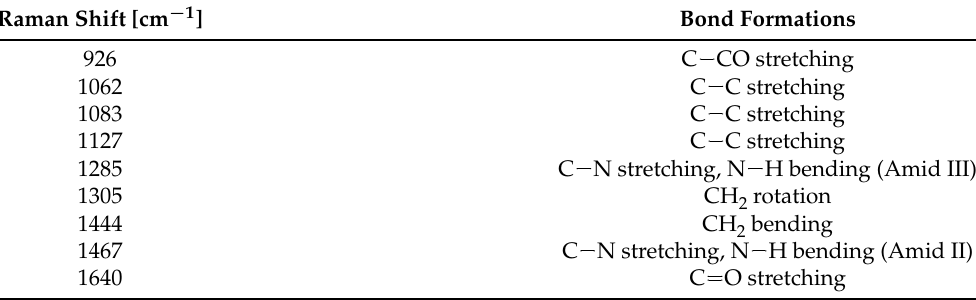
Table 4. Identified and presumed chemical bonds in PA6